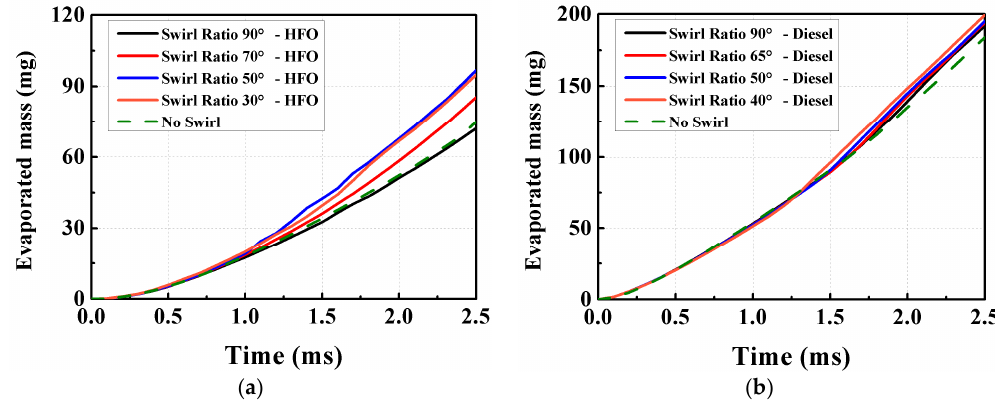
Figure 6. The evolutions of evaporated mass of HFO and Diesel fuels. ( a ) HFO; ( b ) Diesel.